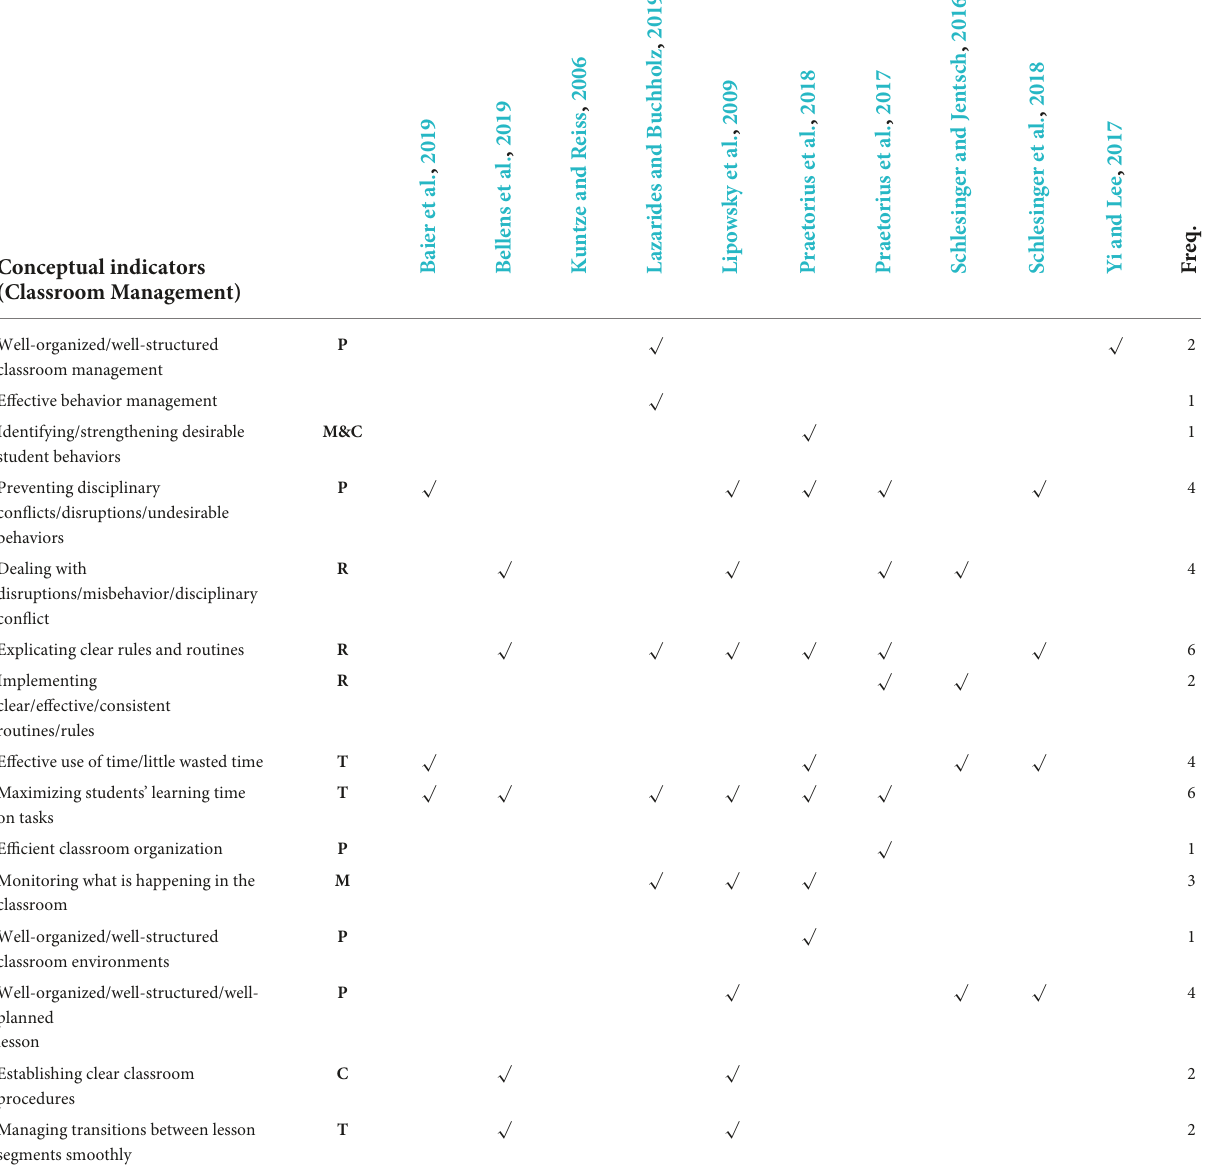
TABLE 3 Overview of conceptual indicators of Classroom Management described by various conceptual definitions in previous studies.